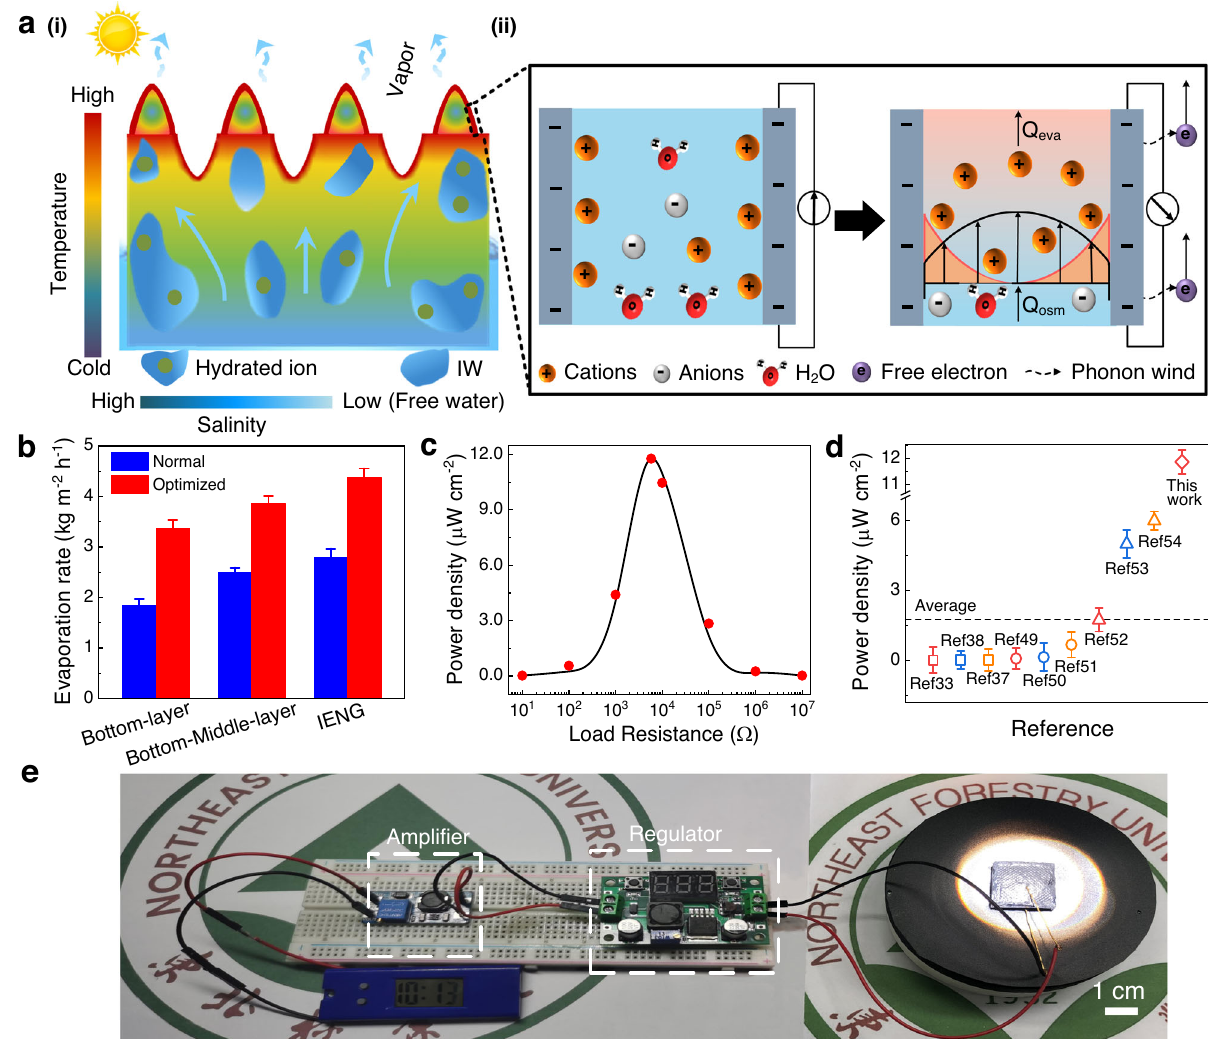
Fig. 5 | Working principle and application of the IENG. a Power generation principle for the IENG induced by water evaporation: (i) Schematic diagram of water fl owing path and evaporation in the IENG, (ii) The left represents schematic diagram of the initial stage, which depicts the speci fi c ion distribution within the channel. And the right is the schematic diagram of the steady state, which depicts theiontransportationintheoverlappingelectricdoublelayer. b Waterevaporation rateoftheIENGinasimulatedmarineenvironment.Thenormalenvironmenthada